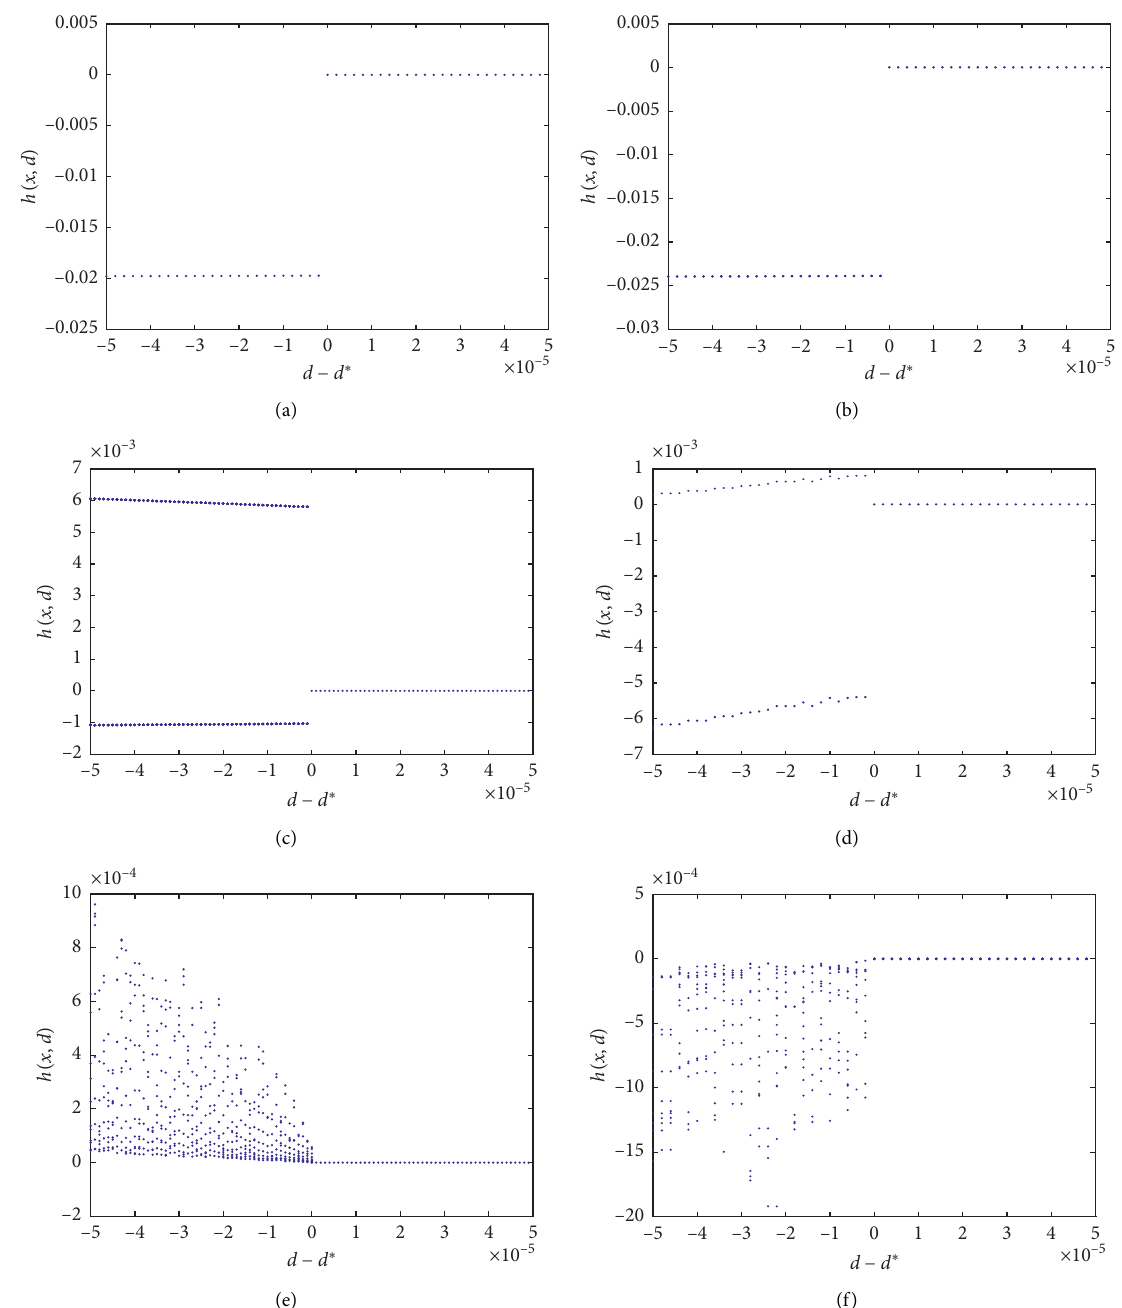
Figure 2: Bifurcation diagram from the grazing bifurcation. (a) ( 1/1 ) impact periodic motions based on the numerical simulation obtained by the discontinuity maps (19) and (20). (b) Direct numerical simulation on Poincar´e section Π of ( 1/1 ) impact periodic motions. (c) ( 1/2 ) 2 impact periodic motions based on the numerical simulation obtained by the discontinuity maps (19) and (20). (d) Direct numerical simulation on Poincar´e section Π of ( 1/2 ) impact periodic motions. (e) The codimension-two grazing bifurcation points based on the 2 of the numerical simulation obtained by the discontinuity maps (19) and (20). (f) Direct numerical simulation on Poincar´e section Π 2 codimension-two grazing bifurcation